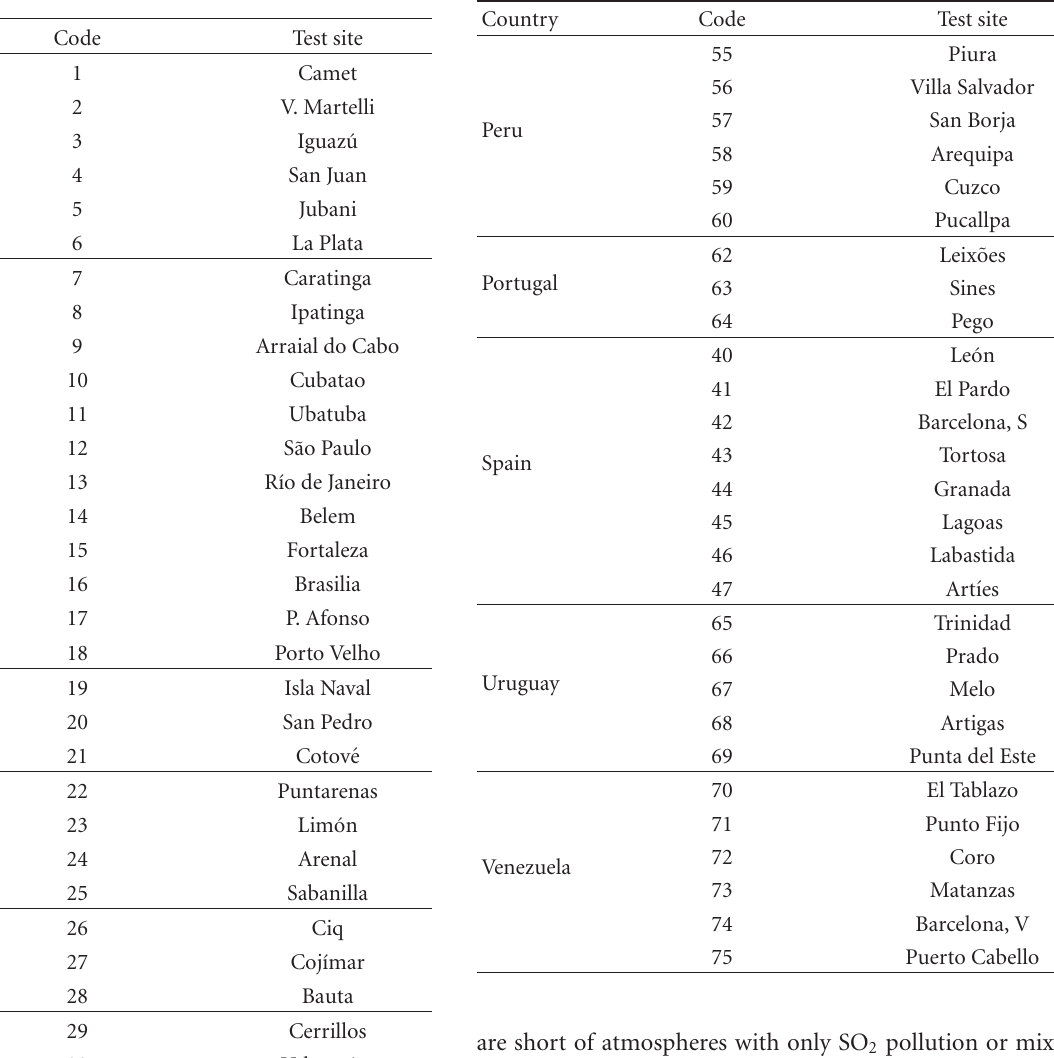
Table 2: List of MICAT test